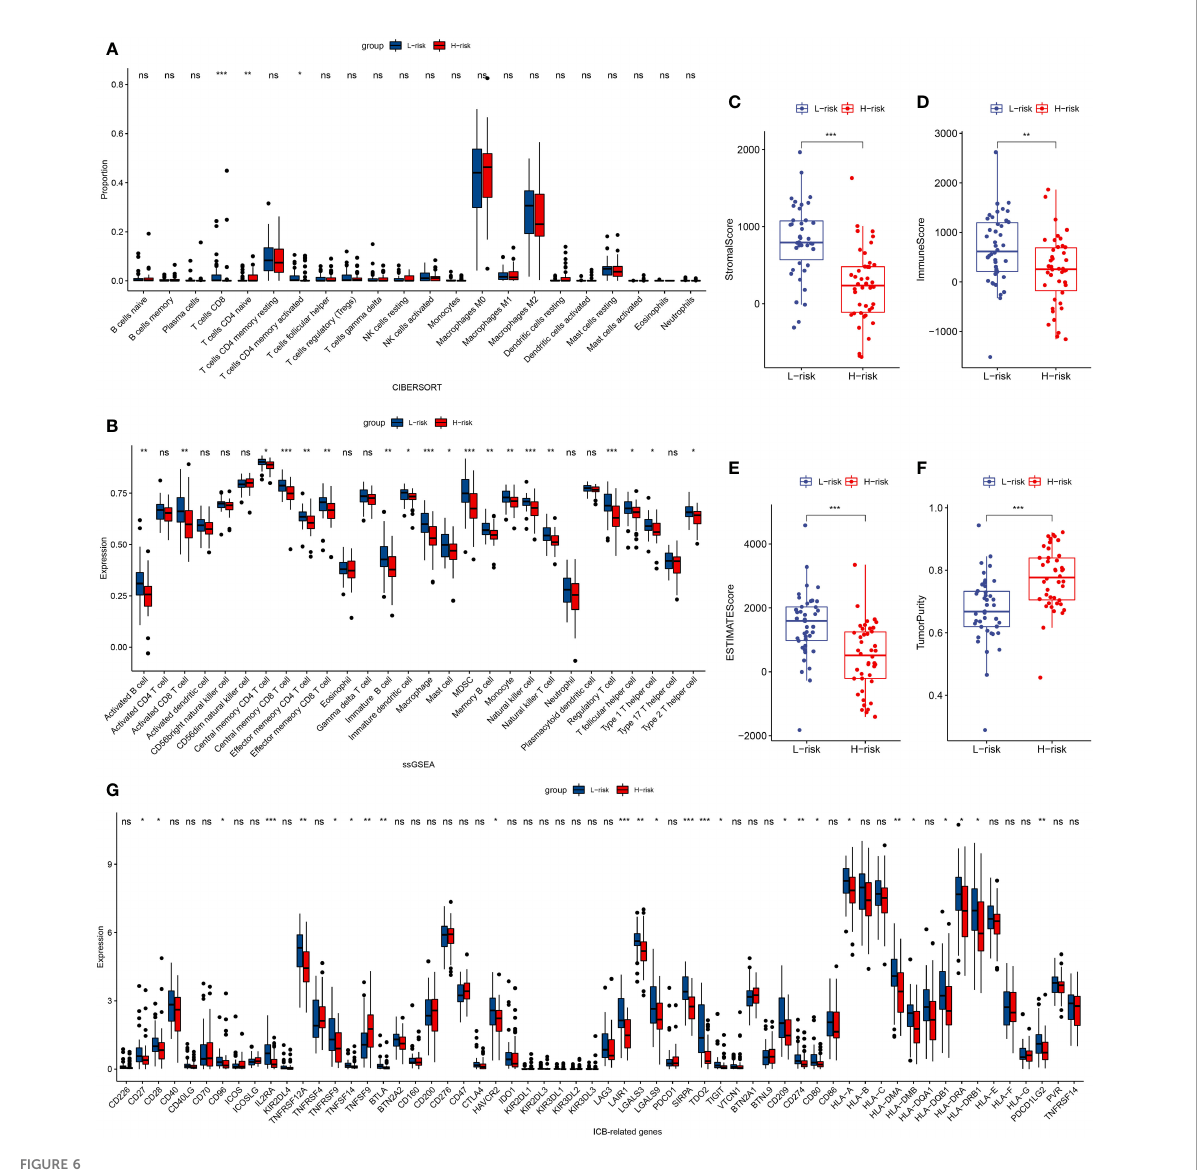
FIGURE 6 TCGA tumor microenvironment between the high-risk and low-risk groups. (A) Boxplots depicting the CIBERSORT scores of 22 immune cells of the high-risk patients compared to low-risk patients. (B) Boxplots depicting the 29 immune signature ssGSEA scores of the high-risk patients compared to low-risk patients. (C – F) Comparisons between the 2 groups in terms of stomal score, immune score, estimate score, and tumor purity. (G) Expression of ICB-related genes in high- and low-risk groups. *P < 0.05, **P < 0.01, ***P < 0.001, ns, P >